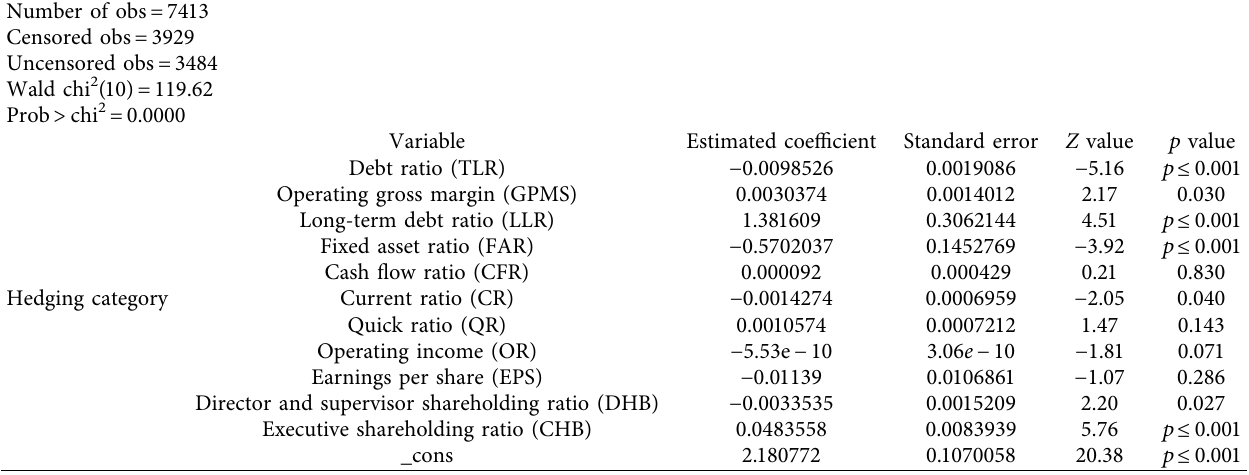
Table 10: Parameter estimation table of the Heckman sample selection